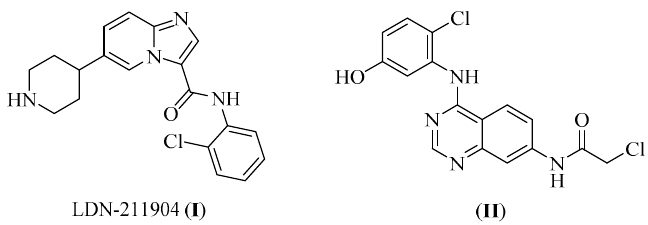
Figure 2. Reported small molecules as selective EphB3 inhibitors.